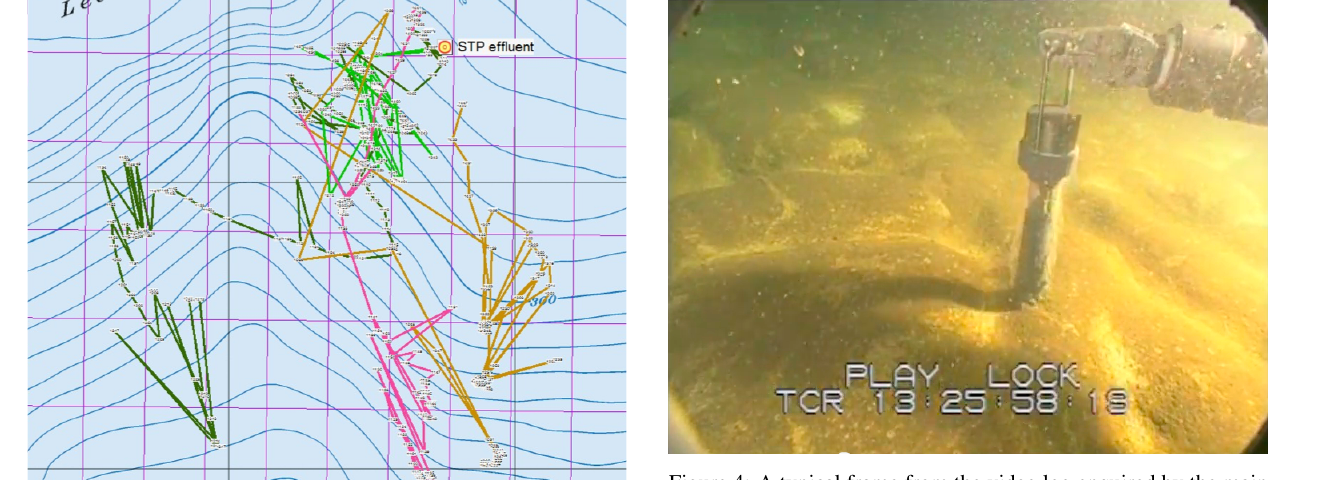
Figure 4: A typical frame from the video log enquired by the main camera of the MIR submersible in the course of the field campaign in lake Geneva. trajectories of the submersibles in the Vidy bay are portrayed in Figure